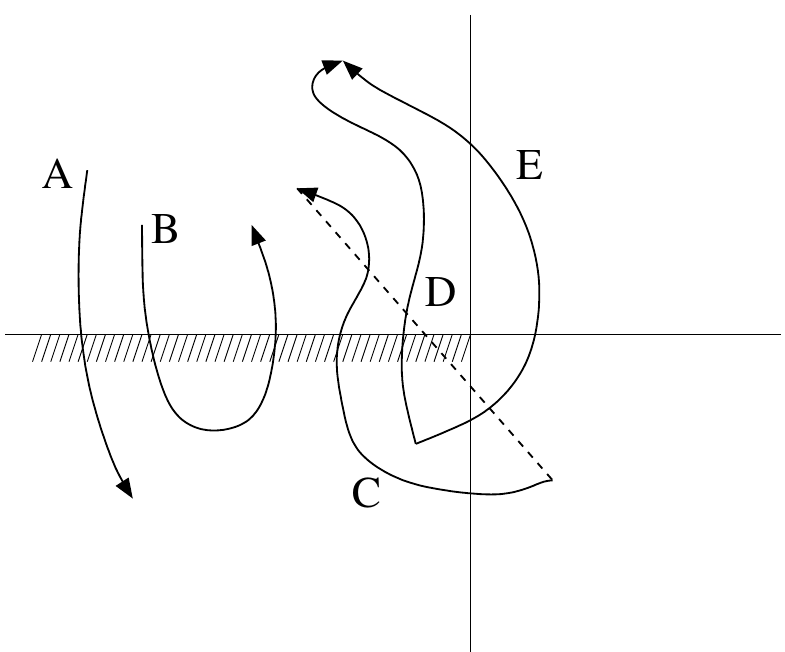
Figure 2. Examples of trajectories, for a function with a branch cut on the negative real axis. The arrow indicates the direction one moves in from (cid:22) (cid:13) = 0 to (cid:22) (cid:13) = (cid:22)(cid:0). See the text for